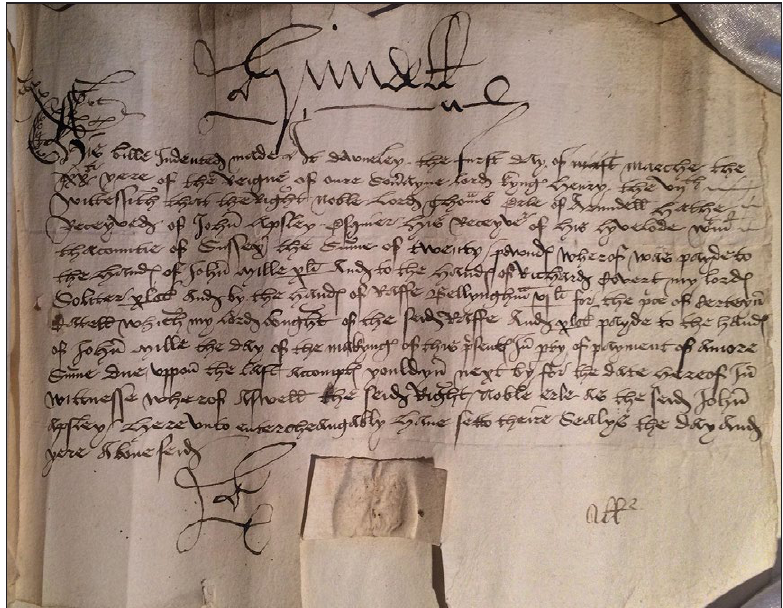
Figure 14: Letter written, signed and sealed at Downley by Thomas Fitzalan on the 1 st March in the 20 th year of Henry VII (1506). Photo: MBR (used with permission of His Grace the Duke of